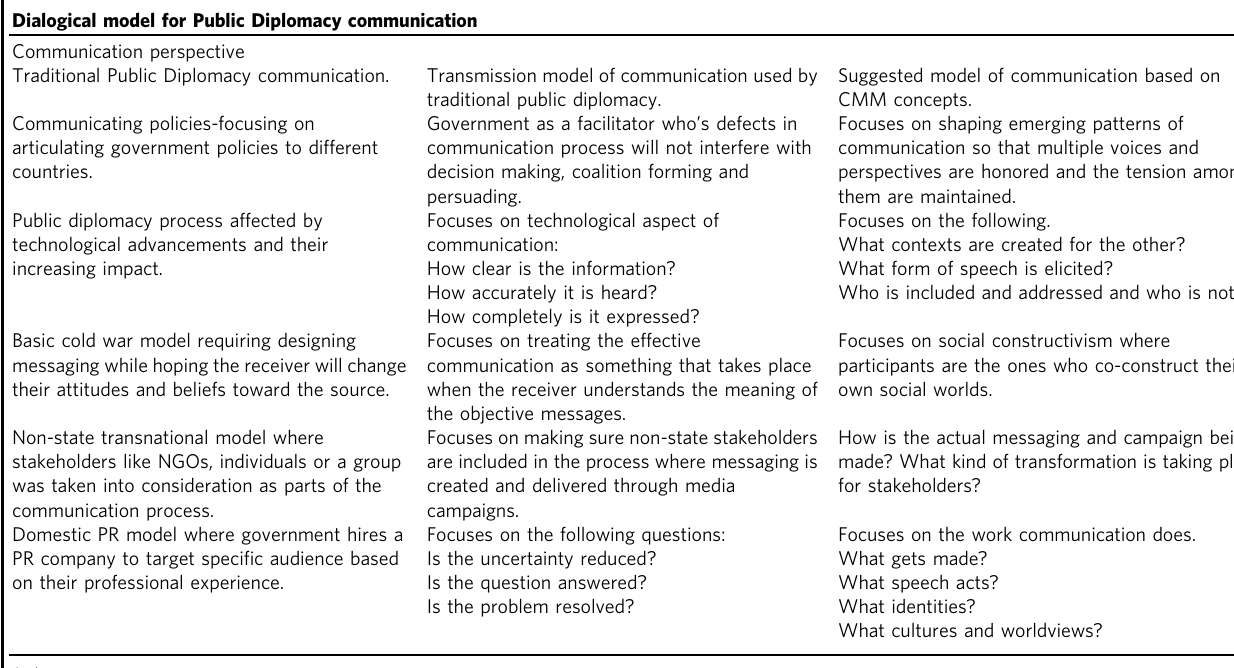
Table 1 Based on the description and explanations by Ross, 2002: p. 77, Gilboa, 2008: p. 59, and Pearce 2007. Dialogical model for Public Diplomacy communication Communication perspective Traditional Public Diplomacy